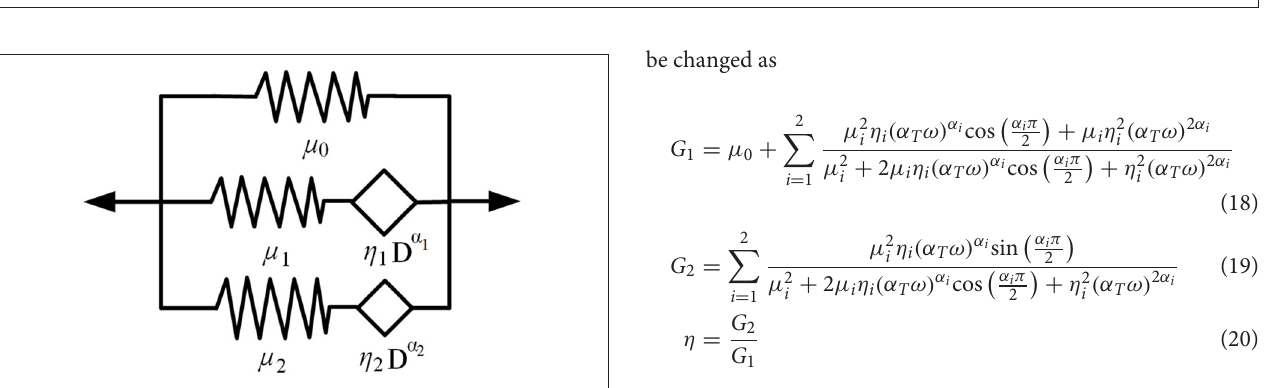
FIGURE 5 | The storage modulus and loss factor of the viscoelastic damper with different test conditions. (A–D) Storage modulus, loss factor, storage modulus, and loss factor, respectively.